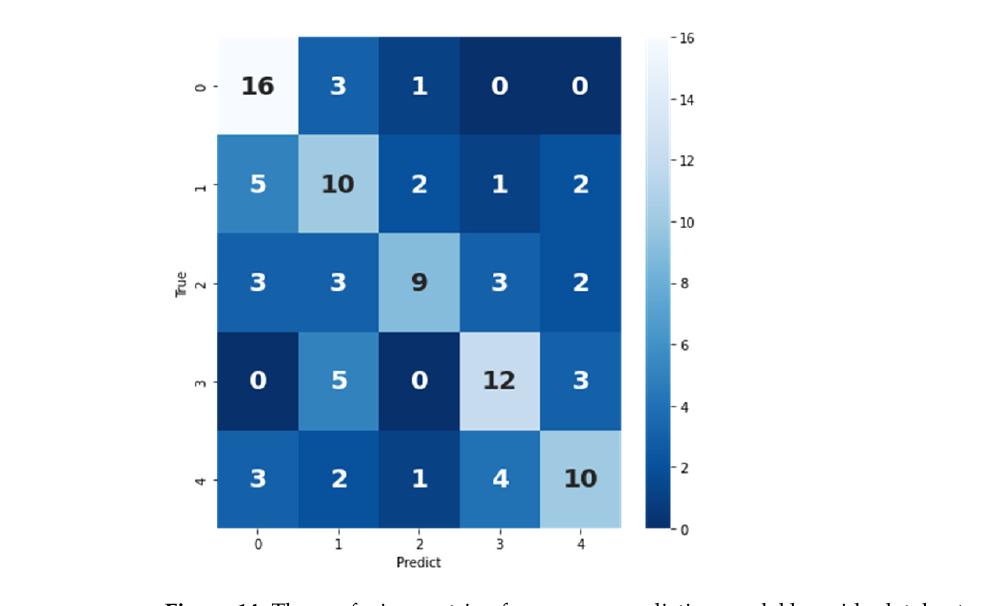
Figure 13. Accuracy of test set verification results of models with different f training times.